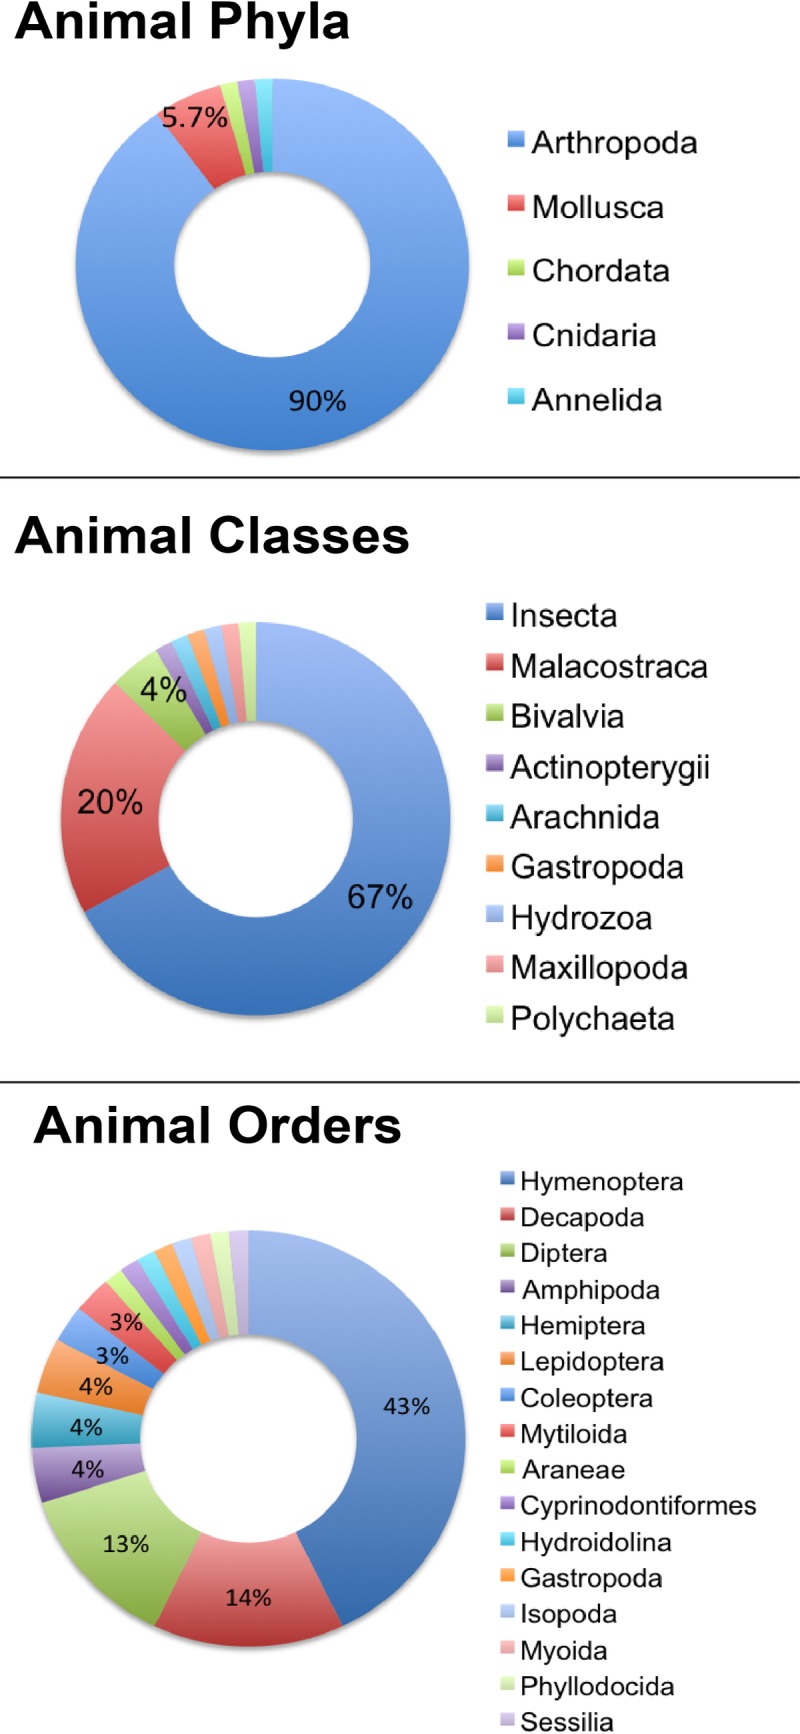
Overview of invertebrates identified by this project, organized by taxonomic level.The vast majority of the animal samples belonged to the phylum Arthropoda (n = 63; 90% of collected animals). Of those 63 samples, most were from the Insecta class (n = 47; 67.1% of collected animals) in the Hymenoptera (n = 30; 42.8% of collected animals) and Diptera (n = 9; 12.8% of collected animals) orders. Taxonomic groups in legends are organized from largest to smallest.